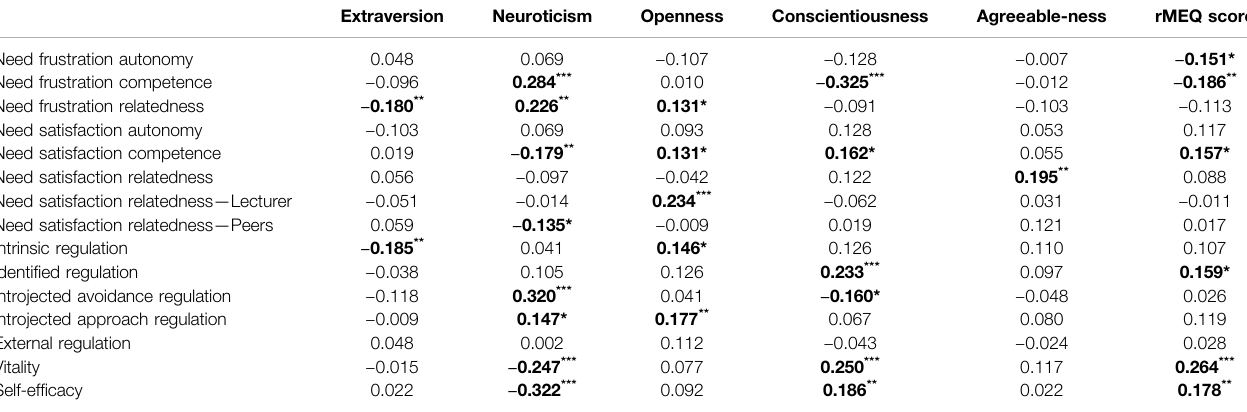
TABLE 2 | Correlation matrix between the independent (personality, chronotype) and dependent variables (basic psychological needs, motivational regulation, vitality, self- ef fi